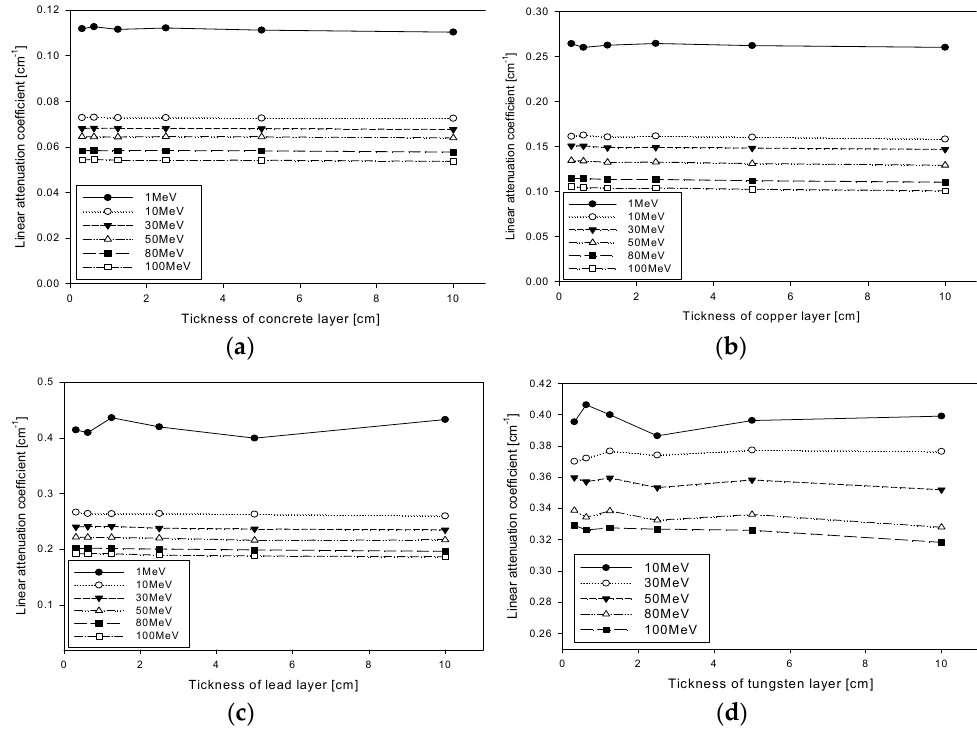
Figure 6. Linear attenuation coefficient of 20 cm laminated composite; ( a ) PE/concrete, ( b ) PE/copper, ( c ) PE/lead, ( d ) PE/tungsten.